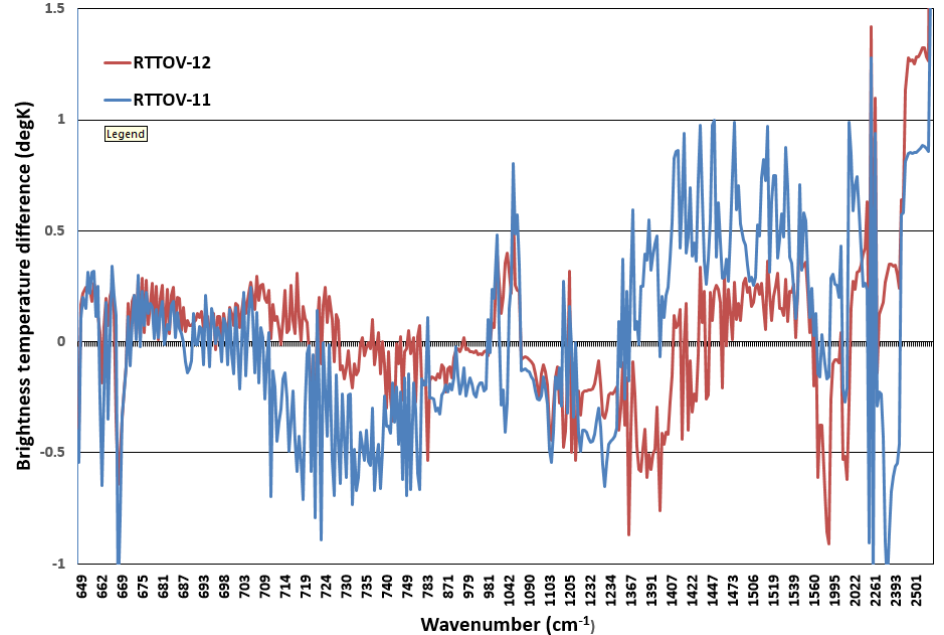
Figure 7. Mean global RTTOV minus observed statistics before bias correction for selected IASI channels for the period 2 May–2 June 2016 for RTTOV versions 11 and 12 in the ECMWF IFS NWP